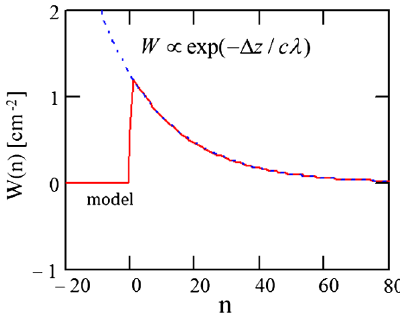
FIG. 12. Electron cloud wake falls exponentially with